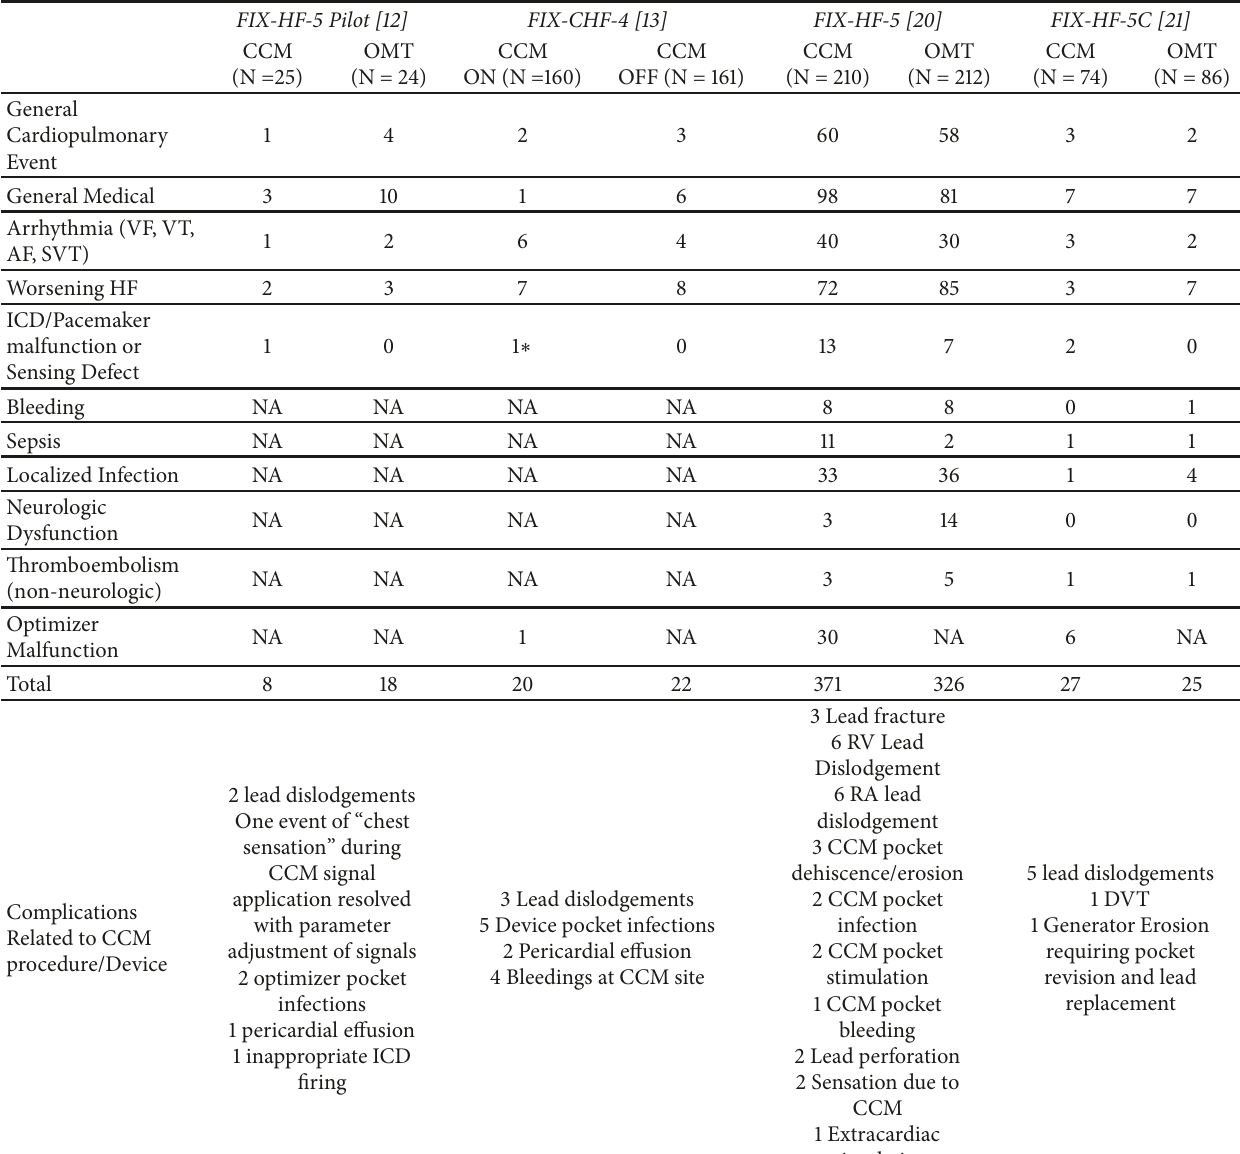
Table 2: A summary of reported adverse events and